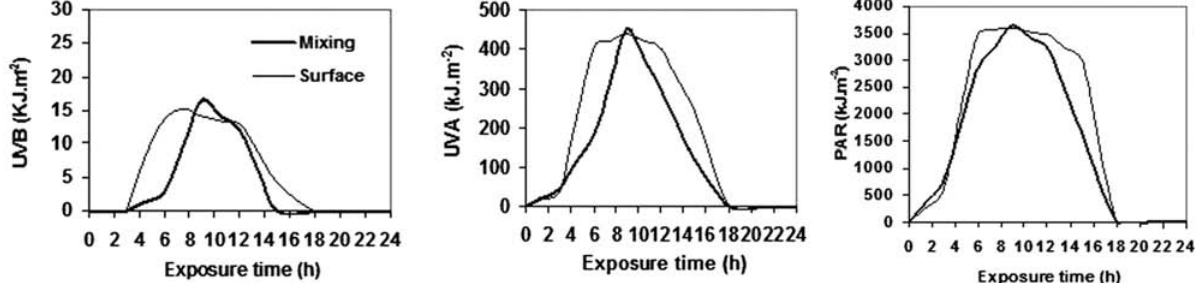
Fig . 1. – Daily irradiance time courses of PAR, UVAR and UVBR in the experimental exposures of Thalassiosira sp. cultures under simulated radiation and simulated surface static (Sfix treatment) and vertical moving (Mix treatment) incubations. Table 1. – Daily doses of PAR, UVAR and UVBR during the ex- perimental exposures of Thalassiosira sp. cultures Static